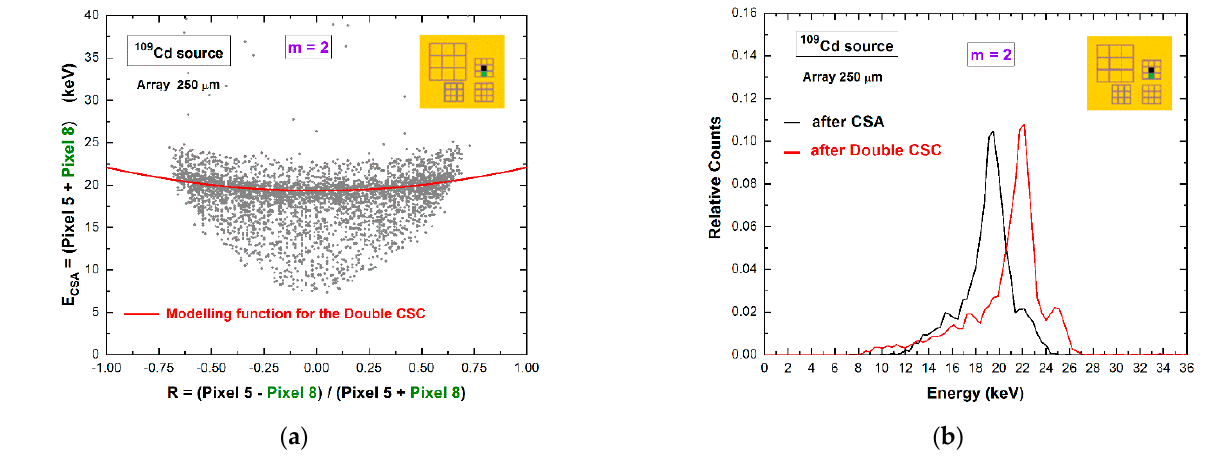
Figure 8. ( a ) Two-dimensional (2D) scatter plot of the summed energy of the coincidence events ( m = 2) between pixel no. 5 and pixel no. 8, after CSA, versus the ratio R (uncollimated 109 Cd source). The red line is the modeling function, a parabola with vertex at the point (0, E CSA ( 0 )) [20], used to correct charge losses. ( b ) The energy spectra after CSA (black line) and after double CSC (red line). The complete recovery of the energy after double CSC and improvements of the energy resolution are clearly visible.